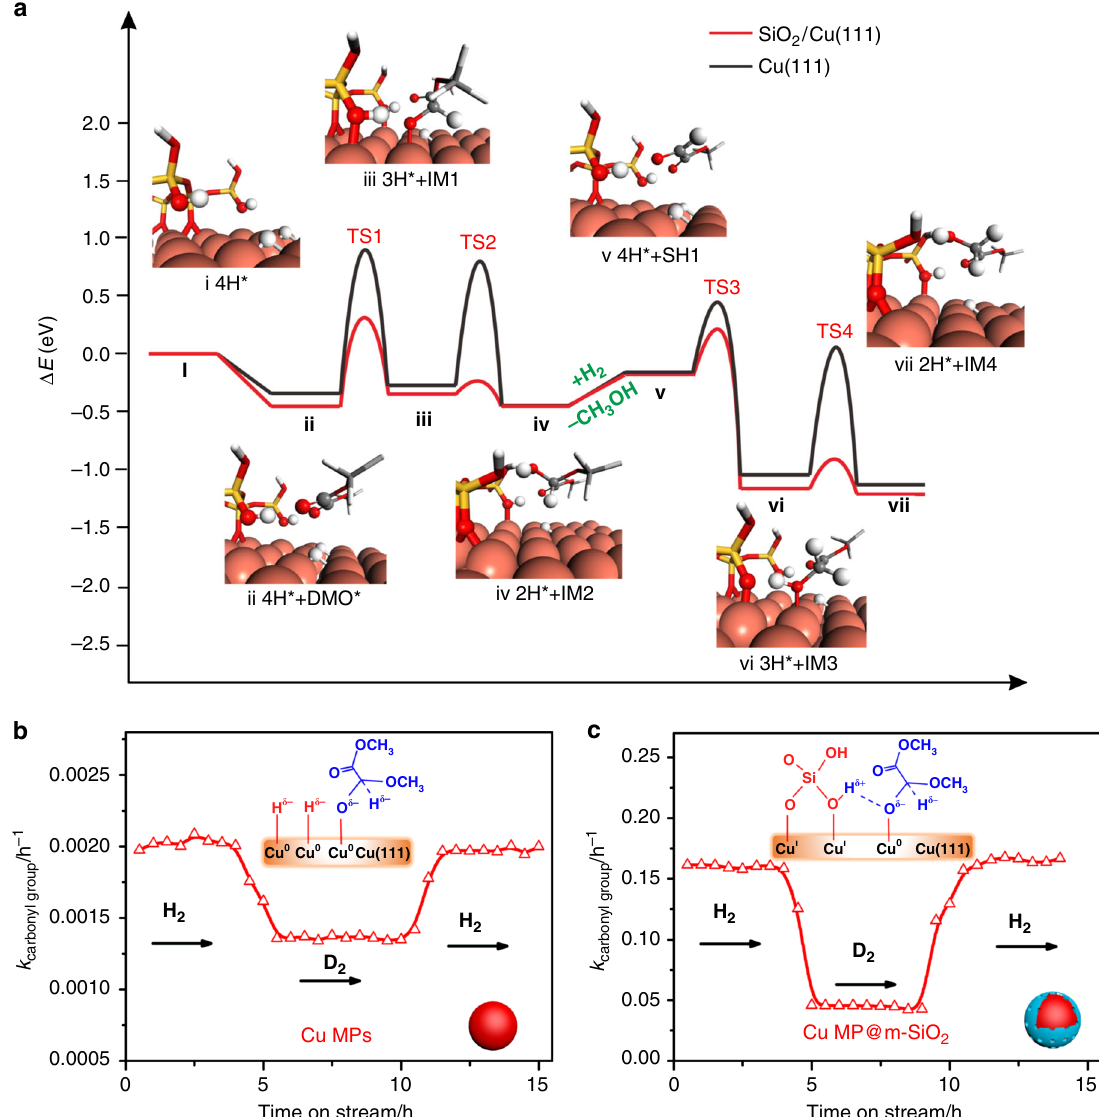
Fig. 2 Mechanism of DMO hydrogenation on Cu – O – SiO x interface. a The DMO hydrogenation pathway on Cu(111) and SiO 2 /Cu(111); b , c The kinetic isotope effect of Cu MPs catalyst and Cu MPs@m-SiO 2 catalyst in hydrogenation of DMO. Reaction conditions were as follows: H 2 /DMO = 80 mol/mol, P (H = 3.0 MPa, T = 230 2 )